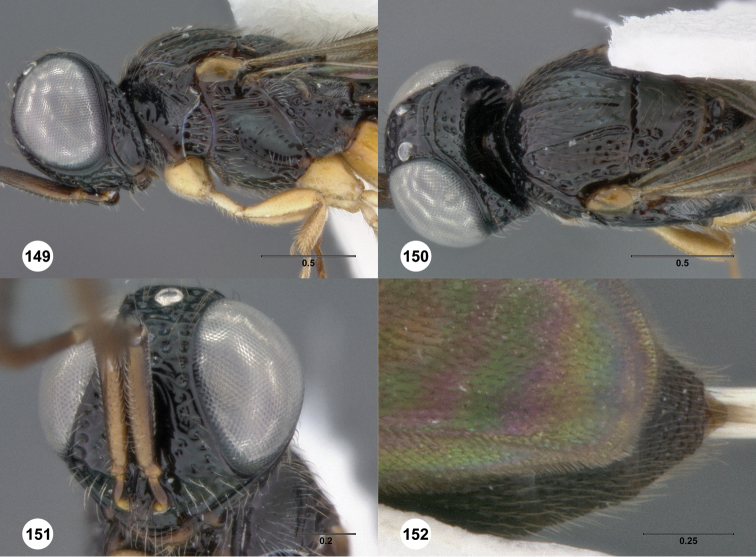
Oxyscelio lenitatis sp. n., holotype female (OSUC 368232) 149 Head and mesosoma, lateral view 150 Head and mesosoma, dorsal oblique view 151 Head, anterior view 152 Metasoma, dorsal view. Morphbank56